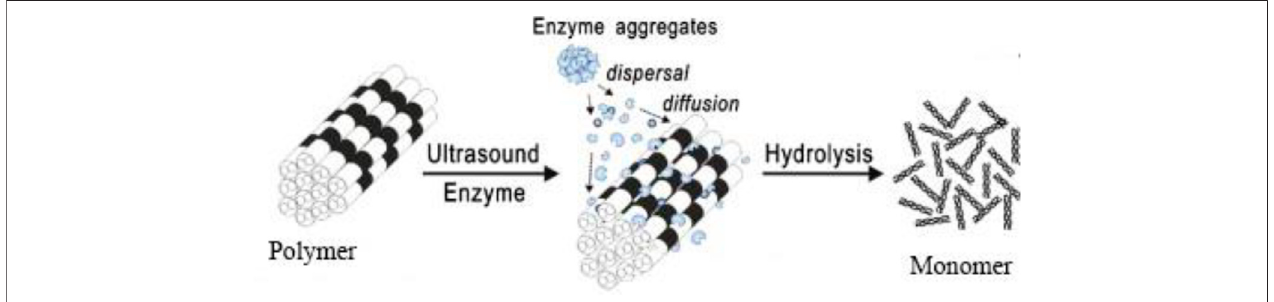
FIGURE8| Mechanismofpreventionofenzymeagglomerationanddepolymerizationoflignocelluloseusingsonication.ReproducedwithpermissionfromGogate (2013).